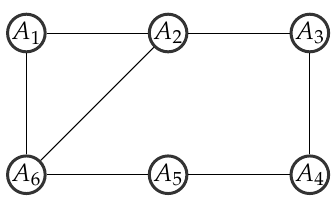
Figure 1. Topology of the multi-agent network in case 1.